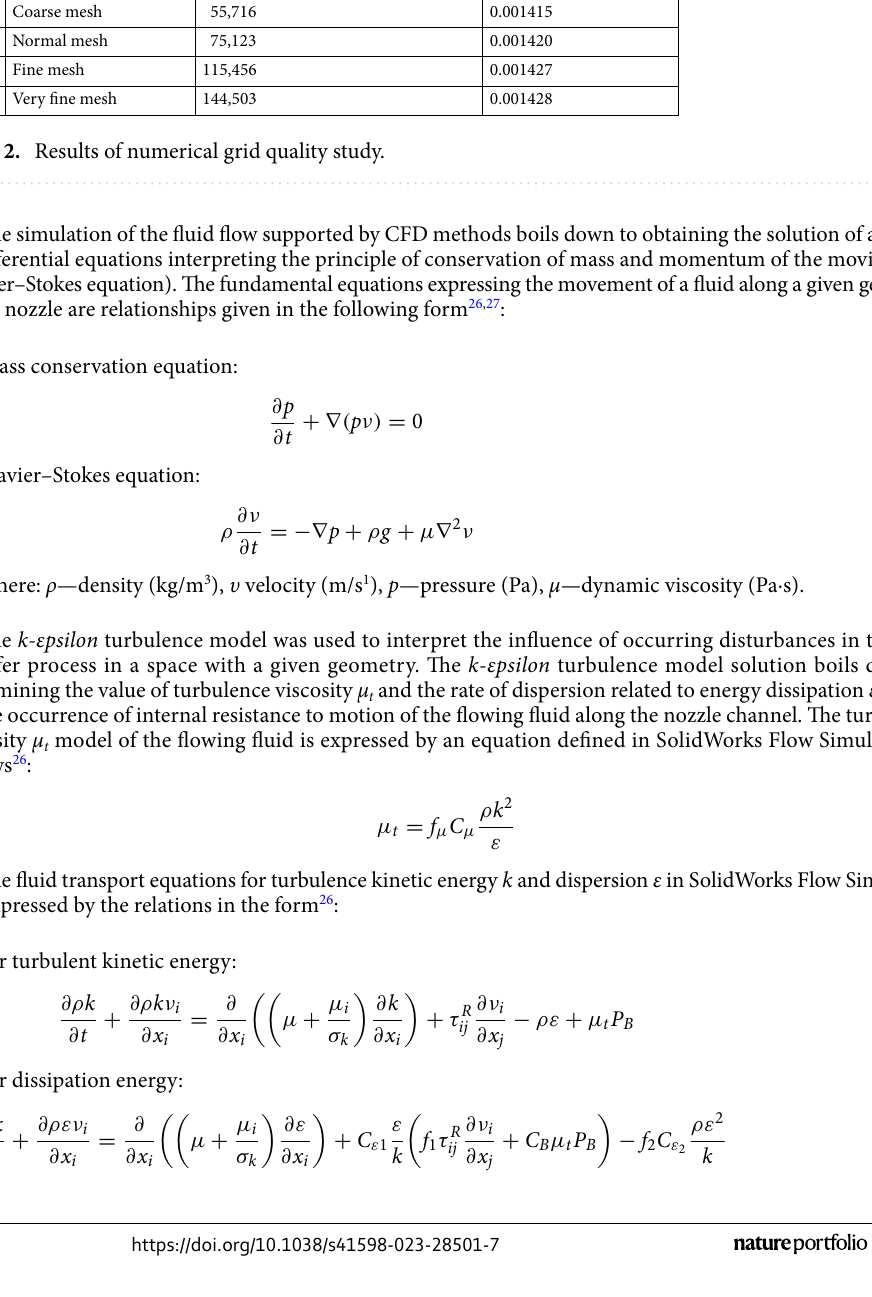
Table 2. Results of numerical grid quality study.